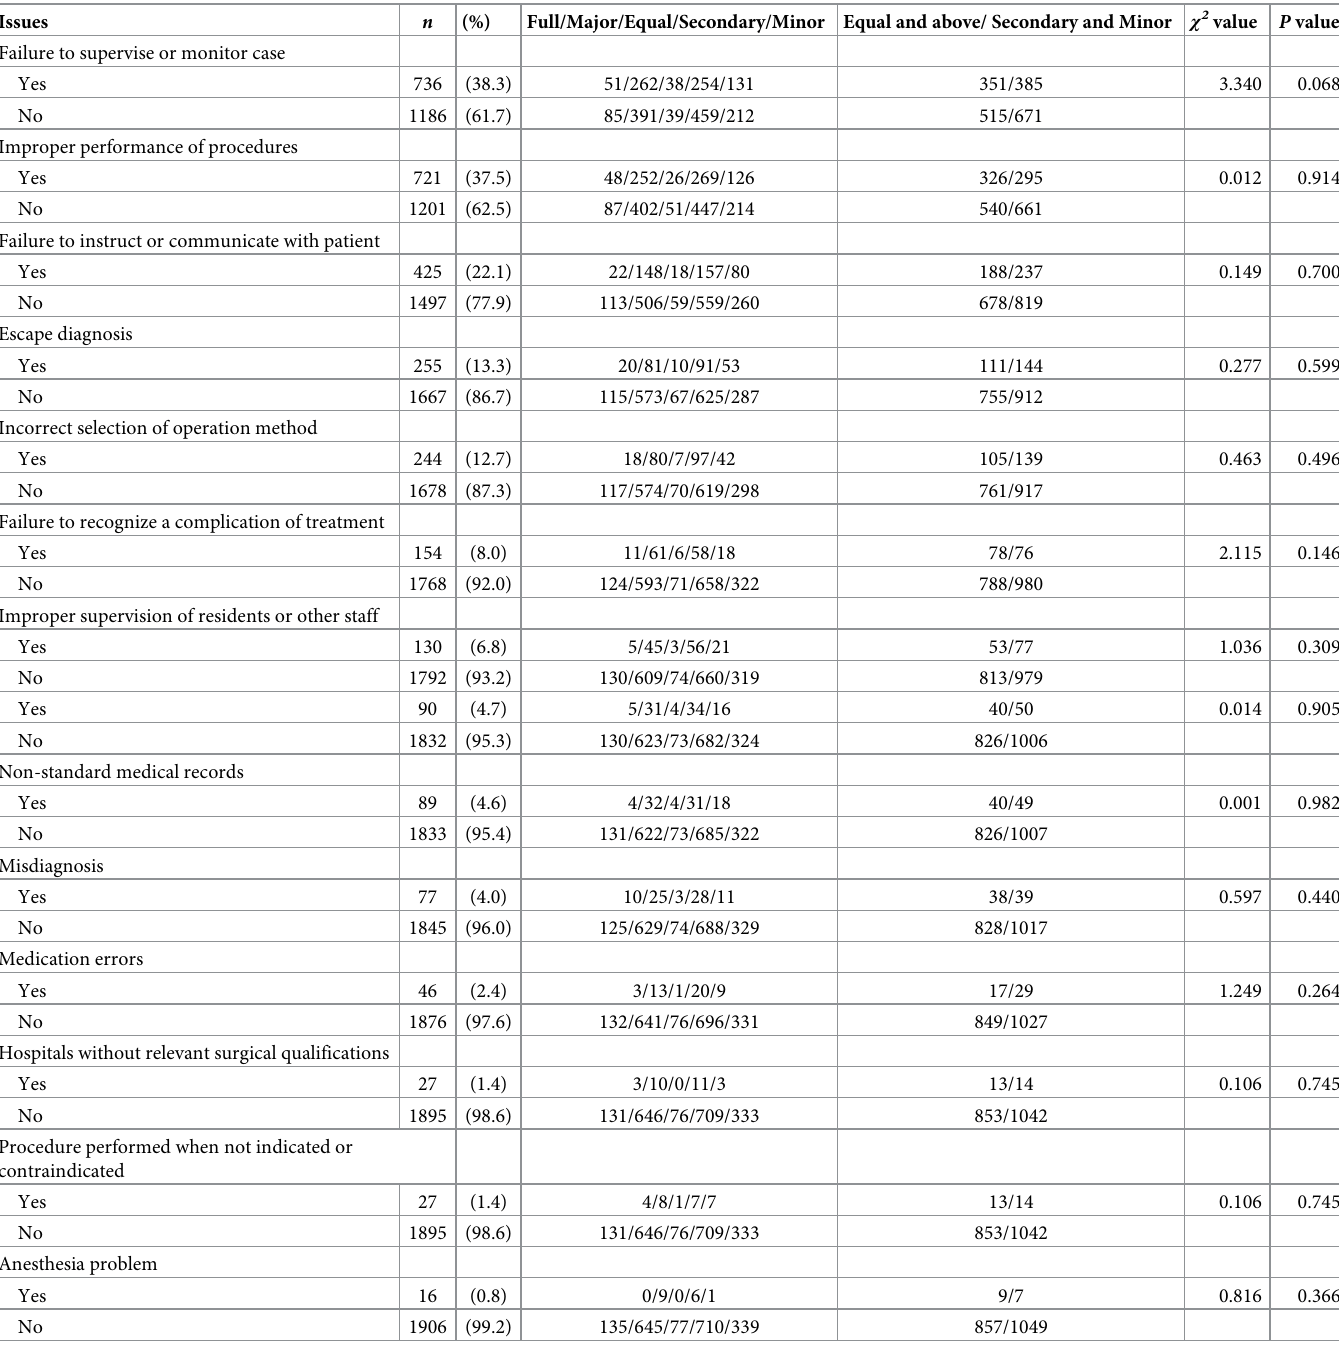
Table 4. Medical error of orthopedist’s degree of responsibility for medical malpractice in China between 2016 and 2017. Issues n (%) Full/Major/Equal/Secondary/Minor Equal and above/ Secondary and Minor χ 2 value P